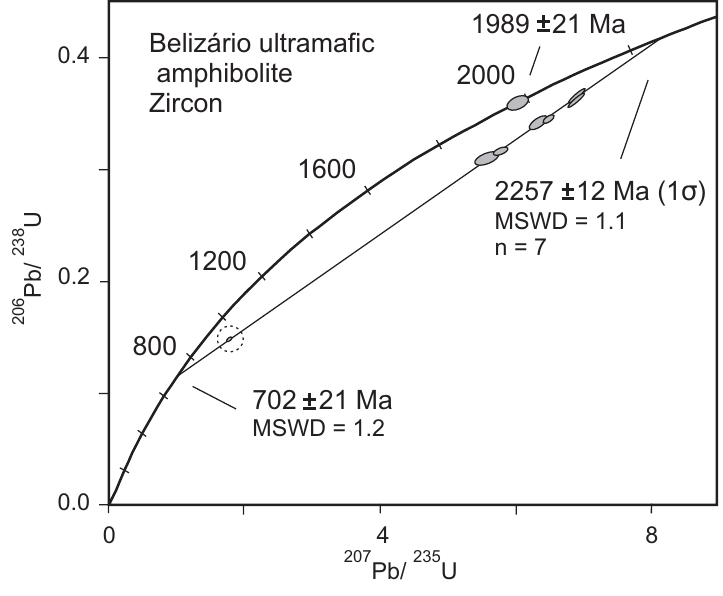
Fig. 6 – Concordia diagram of SHRIMP analyses of zircon crystals from studied rock. One analysis enhanced with a discontinuous